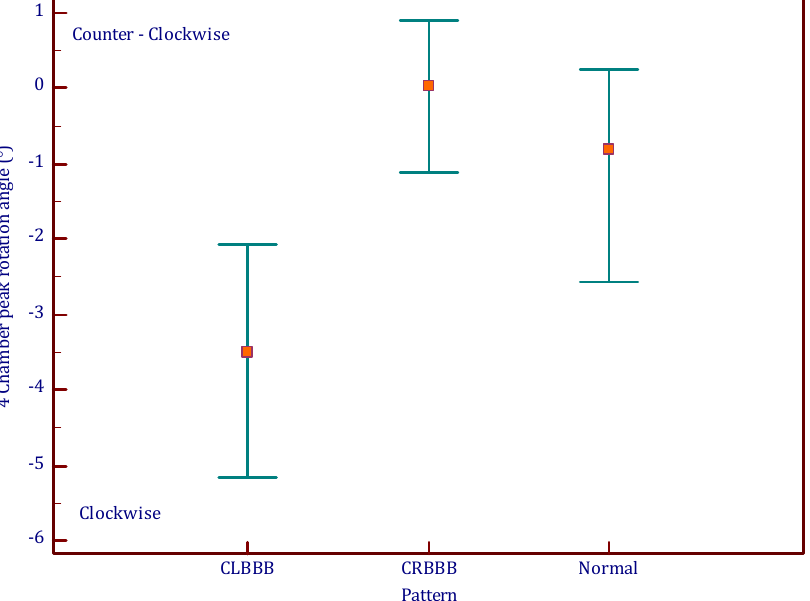
Figure 2. Comparison of longitudinal rotation angle according to conduction pattern. Negative angles are for clockwise rotation, and positive angles are for counterclockwise rotation. In a CRBBB pattern, there was definite and extensive longitudinal counterclockwise rotation. However, this rotation pattern was variable among patients with CRBBB. We found 65% of CRBBB patients had counterclockwise rotation, while 35% had clockwise rotation. CRBBB patients had a significantly lower rate of clockwise rotation compared to the CLBBB patients. Overall, patients with CRBBB had minimal mean rotation (0.1 ± 2.2°), which was significantly less than patients with CLBBB ( p = 0.00001). In patients with a normal QRS pattern (no conduction delay), minimal clockwise rotation was observed. Normal QRS patients had an average rotation of − 1.4 ± 3°, which was signi fi cantly less than the CLBBB patients ( p = 0.005) but not significantly different from the CRBBB patients ( p = 0.093) (Table 1). Clockwise rotation was found among 58% of the normal QRS patients which was not significantly different than among the CRBBB patients (35%, p = 0.15) but significantly lower than the CLBBB patients. Using regression analysis, clockwise rotation was found to be correlated to QRS du- ration in patients with a non-RBBB pattern (LBBB pattern and normal QRS pattern) (Fig- ure 3). As shown in Figure 3, a longer QRS duration resulted in more clockwise rotation (more negative peak rotation angle). Time-to-peak rotation was not different among the groups: 395 ± 98 ms in normal QRS patients, 339 ± 135 ms in CLBBB patients, and 367 ± 89 ms in CRBBB patients.